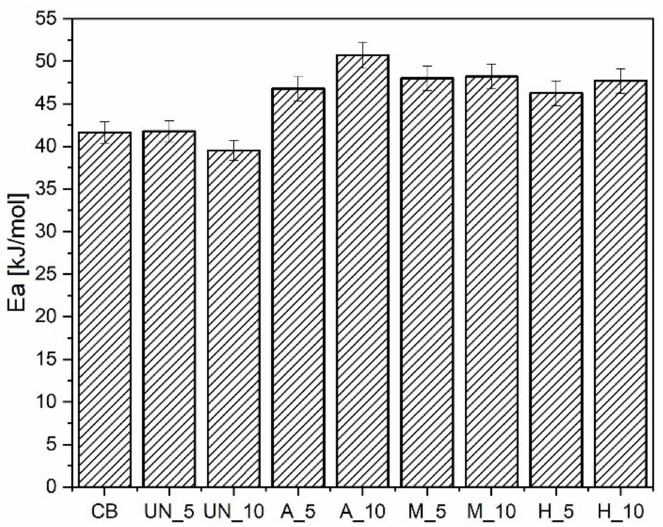
Figure 6. Activation energy of vulcanization for the samples containing GTR.